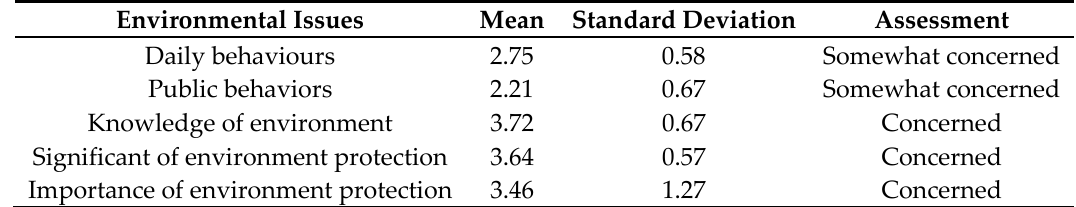
Table 2. Mean and standard deviation of environmental knowledge and daily behaviours.